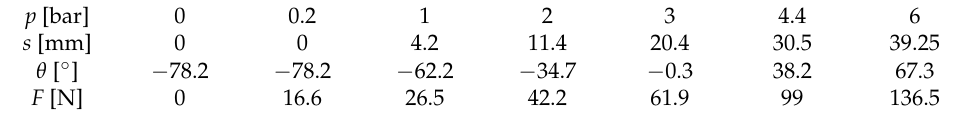
Table 3. Value sets ( p , s , θ , F ) that ensure the adjustable compliance of the rehabilitation